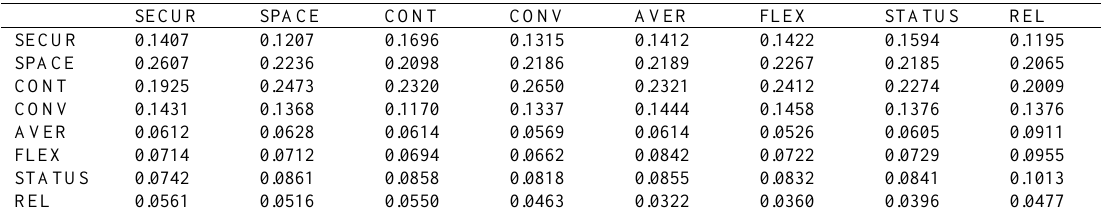
Table 4. Normalized matrix.